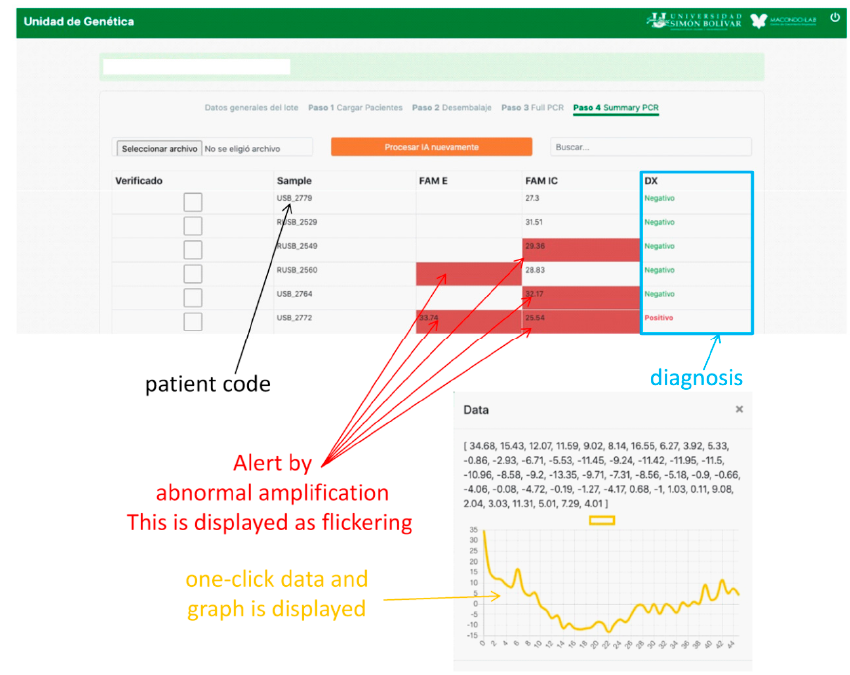
Figure 6. Web platform design for the implementation of AI.